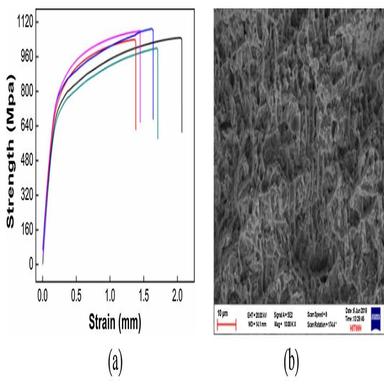
The tensile property of graded materials: (a) The tensile strain-strength curve. (b) Fractographs of broken pieces.